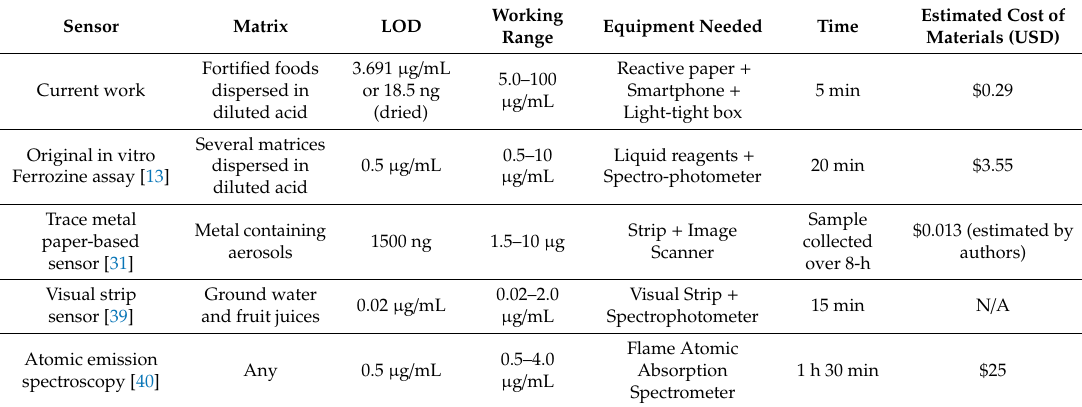
Table 2. Comparison of iron determination